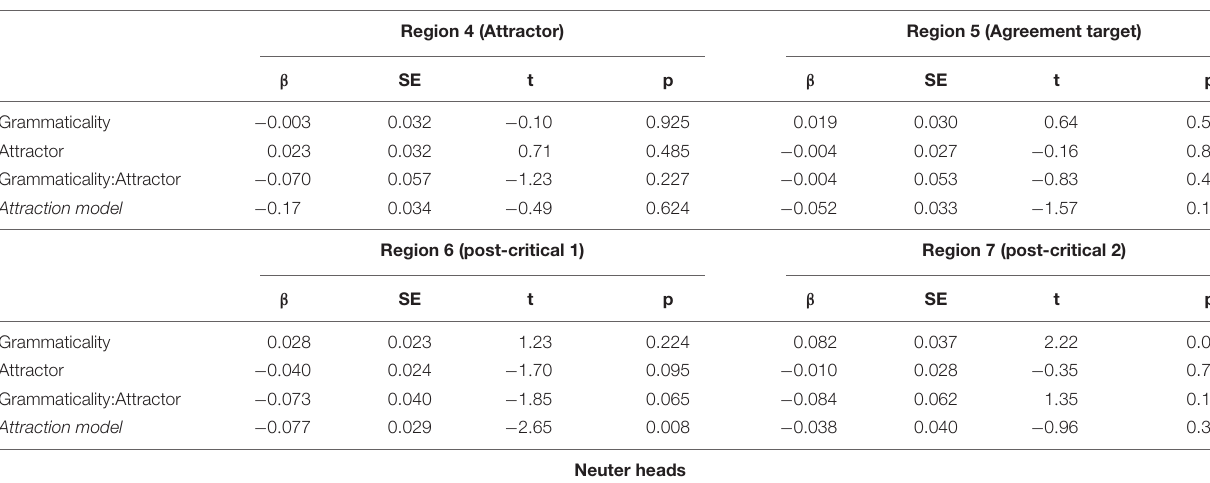
TABLE 4 | Linear mixed-effects model results in Experiment 2 with feminine and neuter heads. Feminine Heads Region 4 (Attractor) Region 5 (Agreement